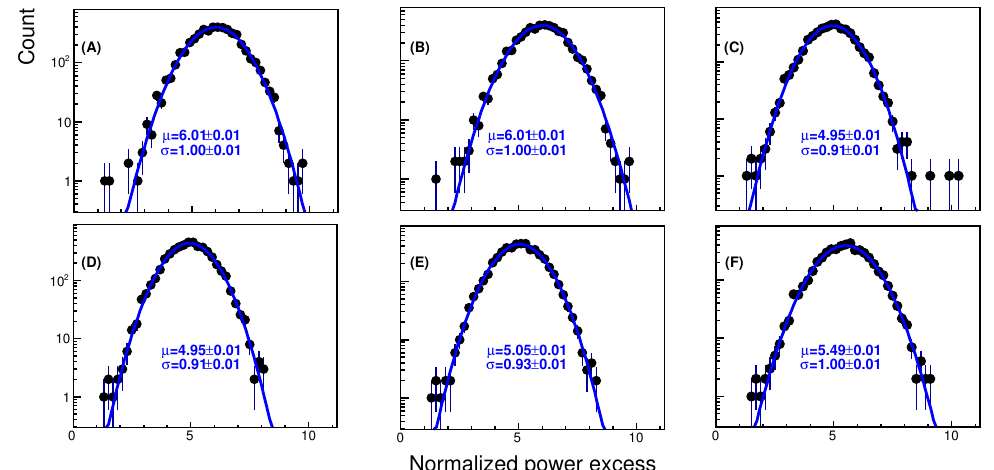
Figure 8 . Normalized grand power excess distributions from the 5000 simulated CAPP-8TB experiments at the simulated axion signal frequency, where the conditions for (A) to (F) are listed in table 1. Lines are a Gaussian fit resulting in µ and σ